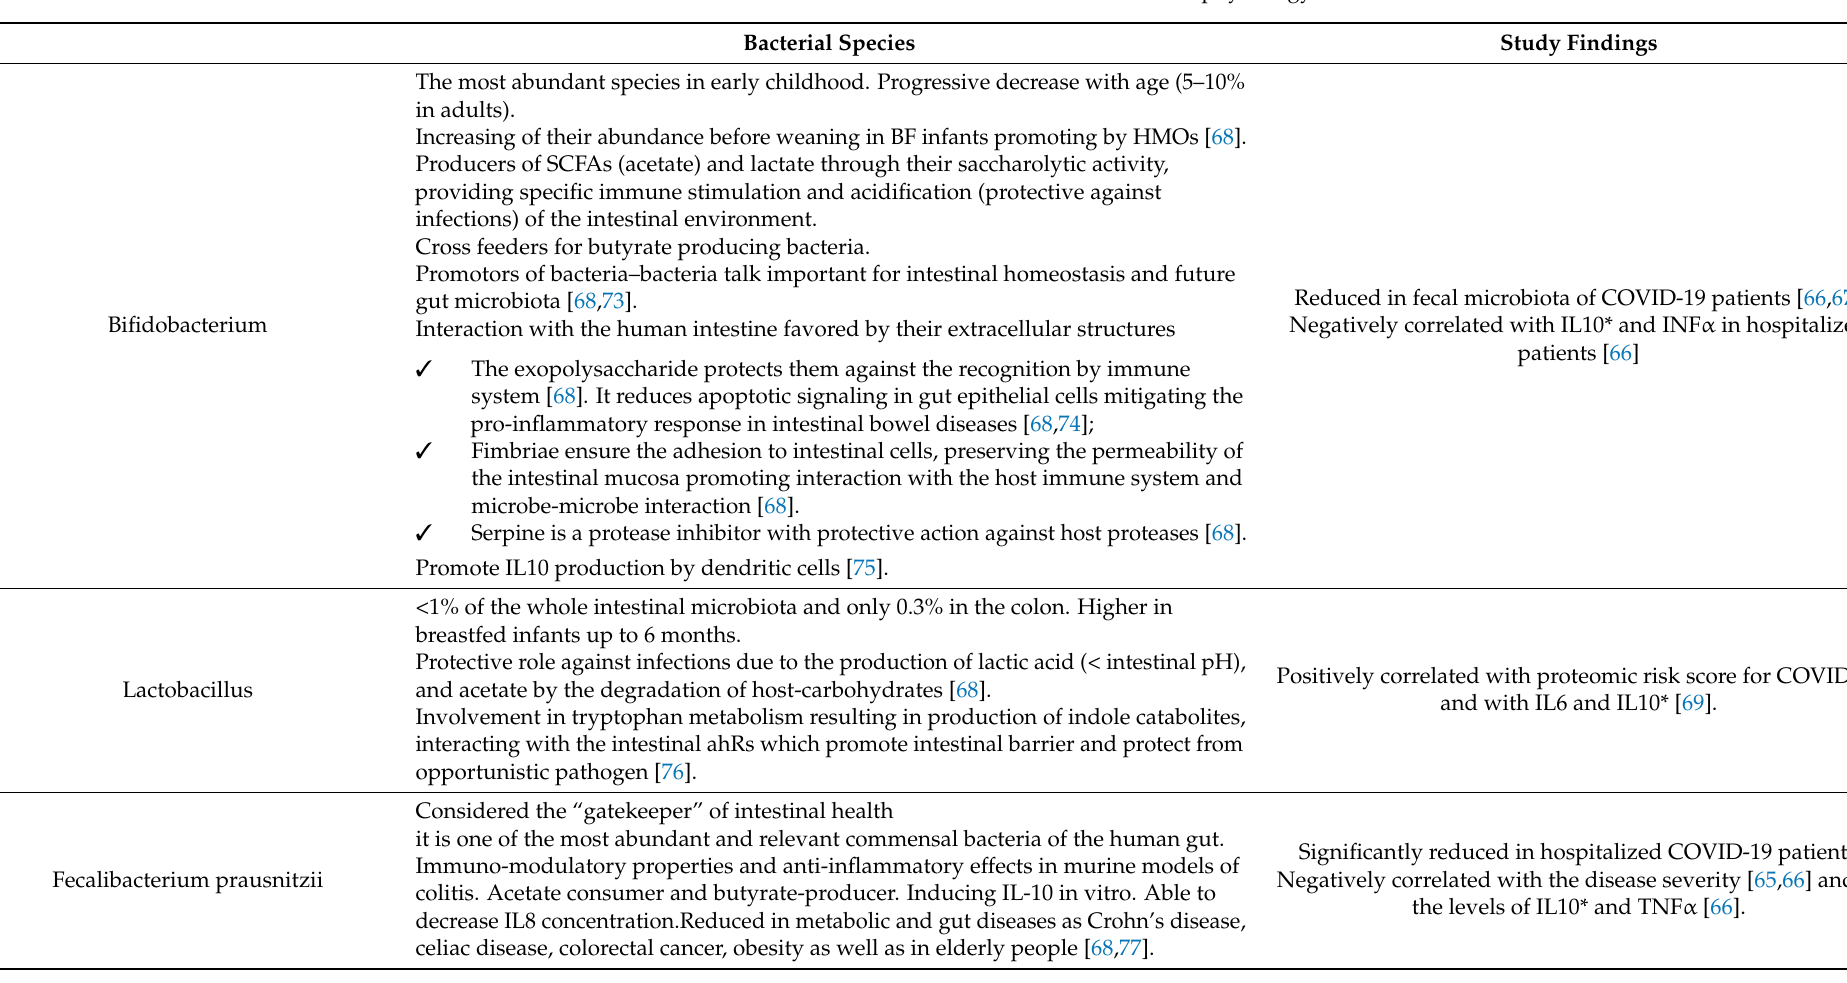
Table 1. Gut commensals involved in COVID-19 and their correlations to host physiology and diseases.